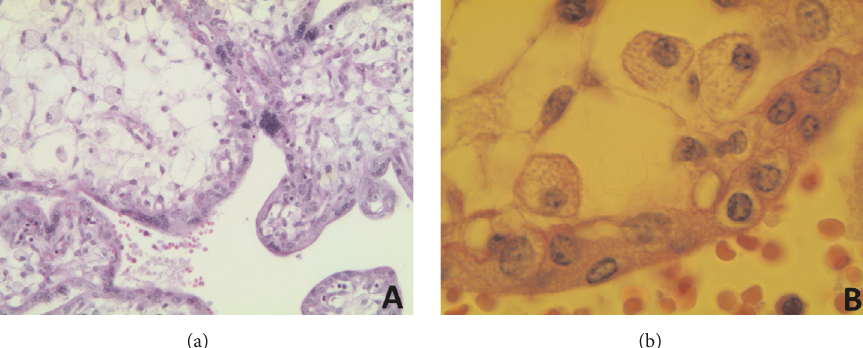
Figure 1: Overview of main histopathological findings. (a) and (b) Placental histopathological results showing a rather loose villous stroma with numerous foamy/vacuolated Hofbauer cells. Periodic Acid-Schiff (PAS) stain; original magnifications: × 200 (a) and × 1000 (b).